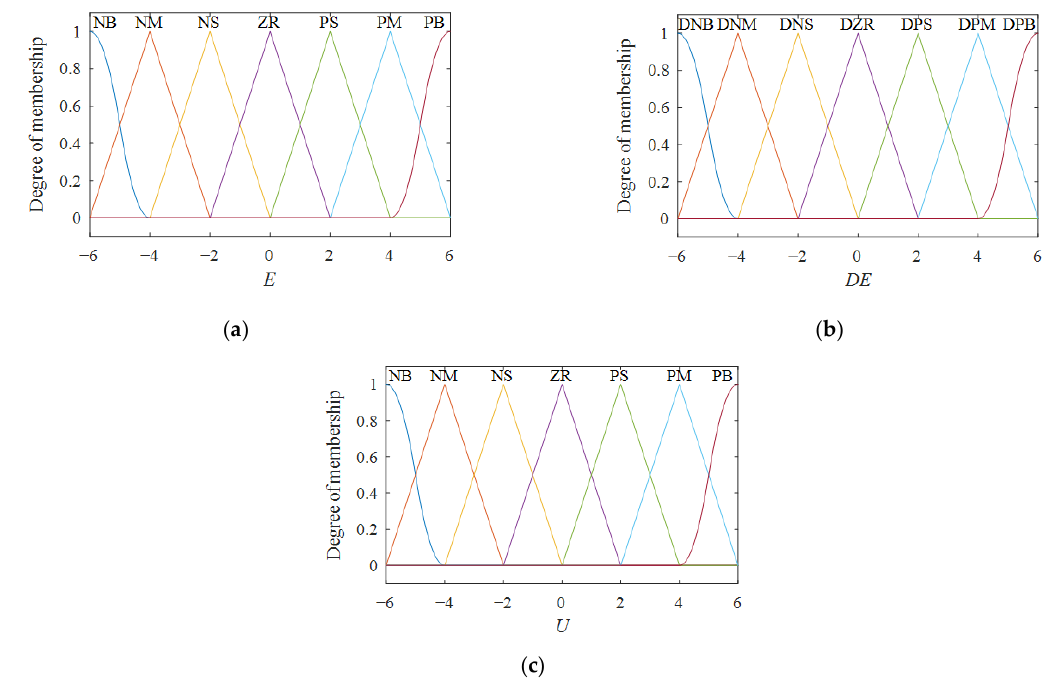
Figure 8. Fuzzy set membership function: ( a ) Input fuzzy set E ; ( b ) Input fuzzy set DE ; ( c ) Output fuzzy set U . Table 2. Fuzzy control